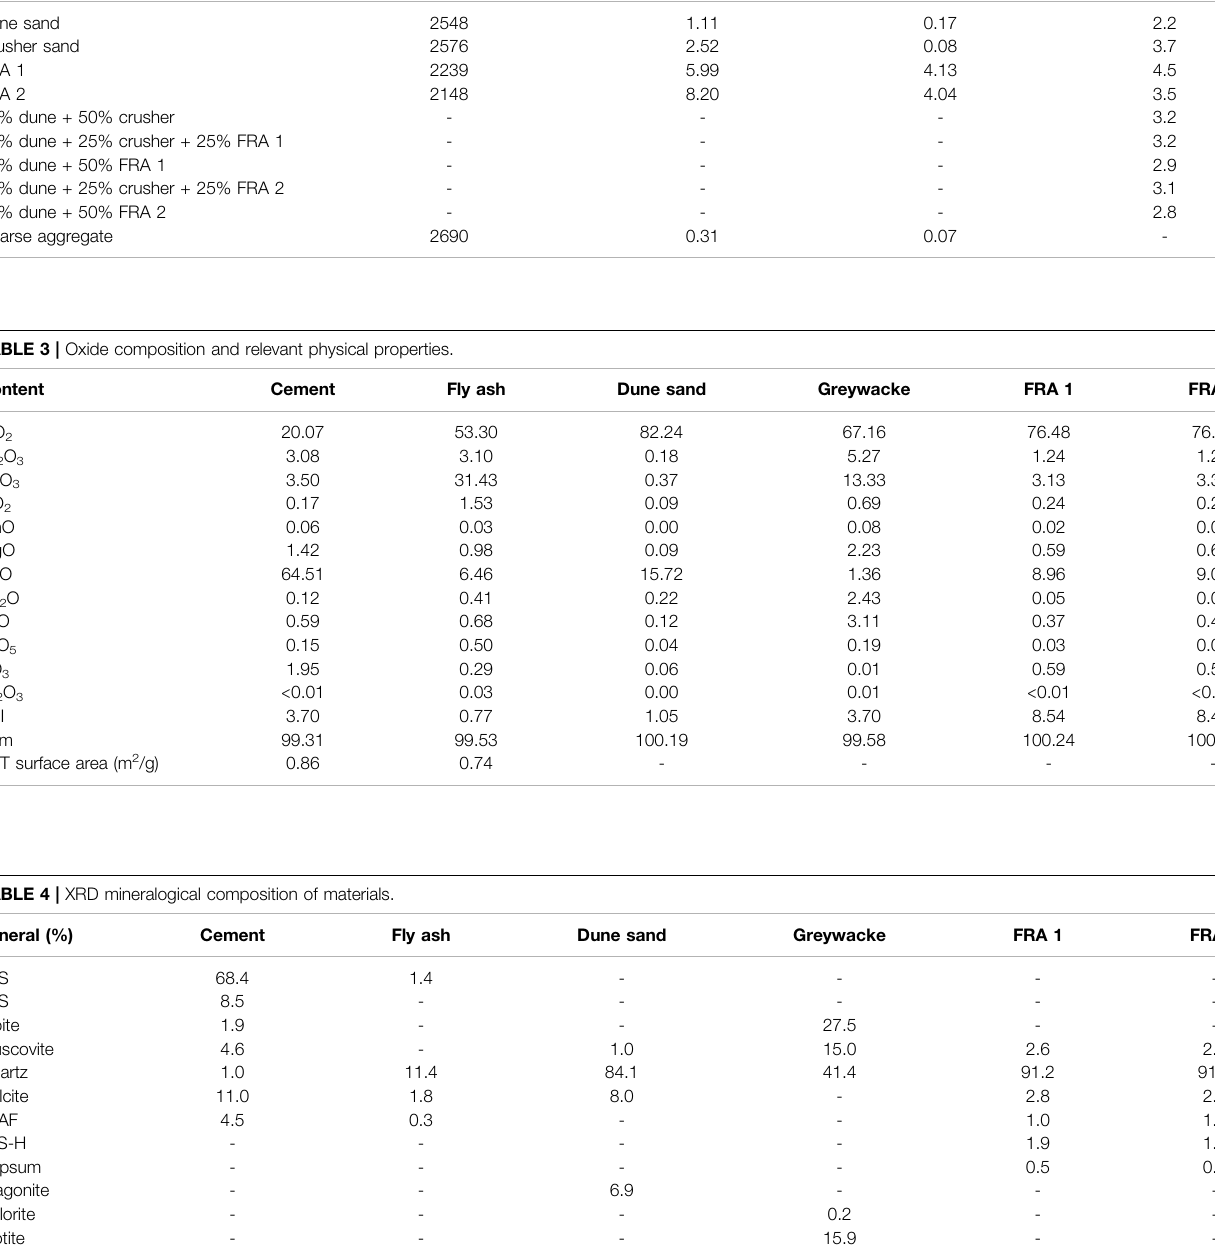
TABLE 2 | Physical properties of natural aggregates and fi ne aggregate combinations. Material